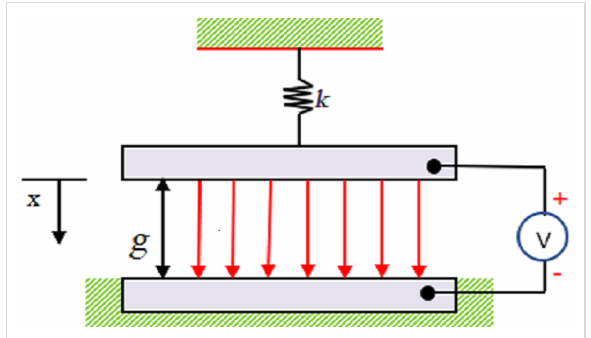
Figure 1: The lumped parameters model of the pull-in phenomenon between parallel plates. Figure 1 was redrawn from [11].